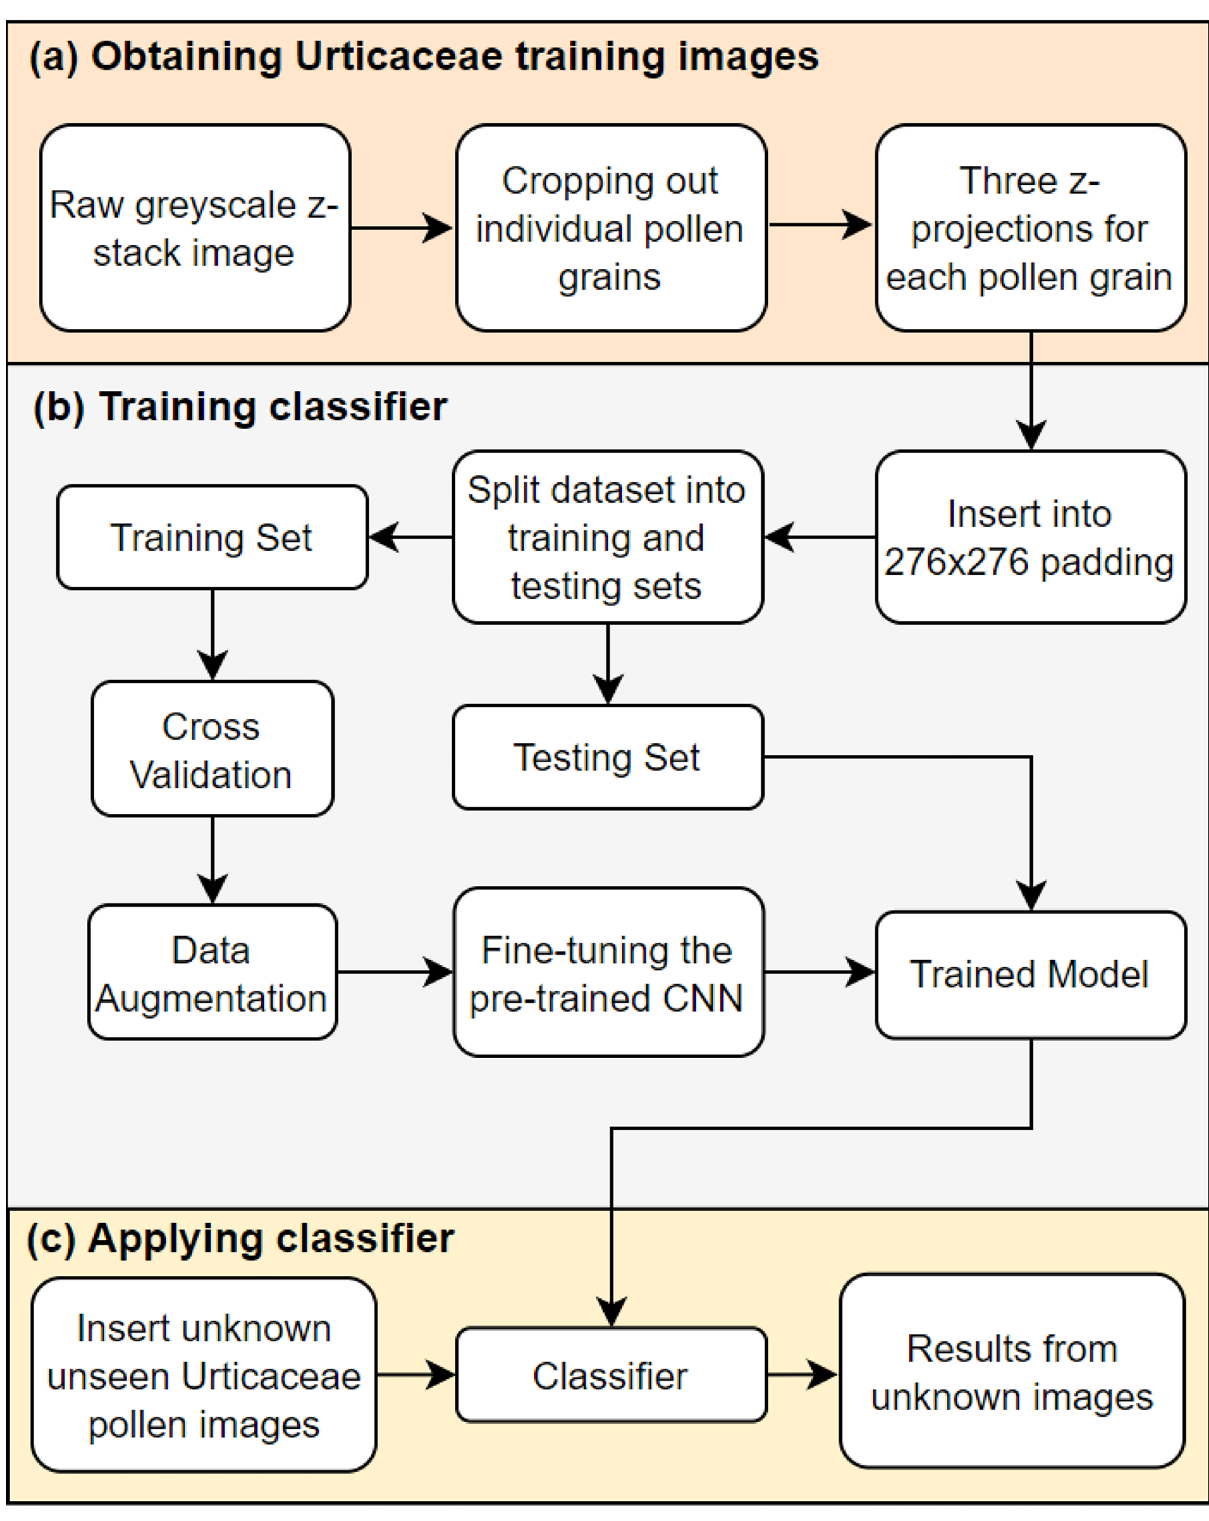
Figure 3. Flowchart showing the pollen image classification process. ( a ) Reference pollen image capture using the custom Fiji macro Pollen_Projector. ( b ) Images were inserted into a fixed frame and split into training and testing sets. The training set was used for cross-validation and data augmentation (flip, brightness) so as to train the CNNs VGG16, MobileNetv1 and MobileNetv2. Results from the models trained from scratch are compared to results from transfer learning on pre-trained models. ( c ) Images from before unseen unknown Urticaceae pollen grains are fed to the resulting classifier. Created using https:// app. diagr ams.